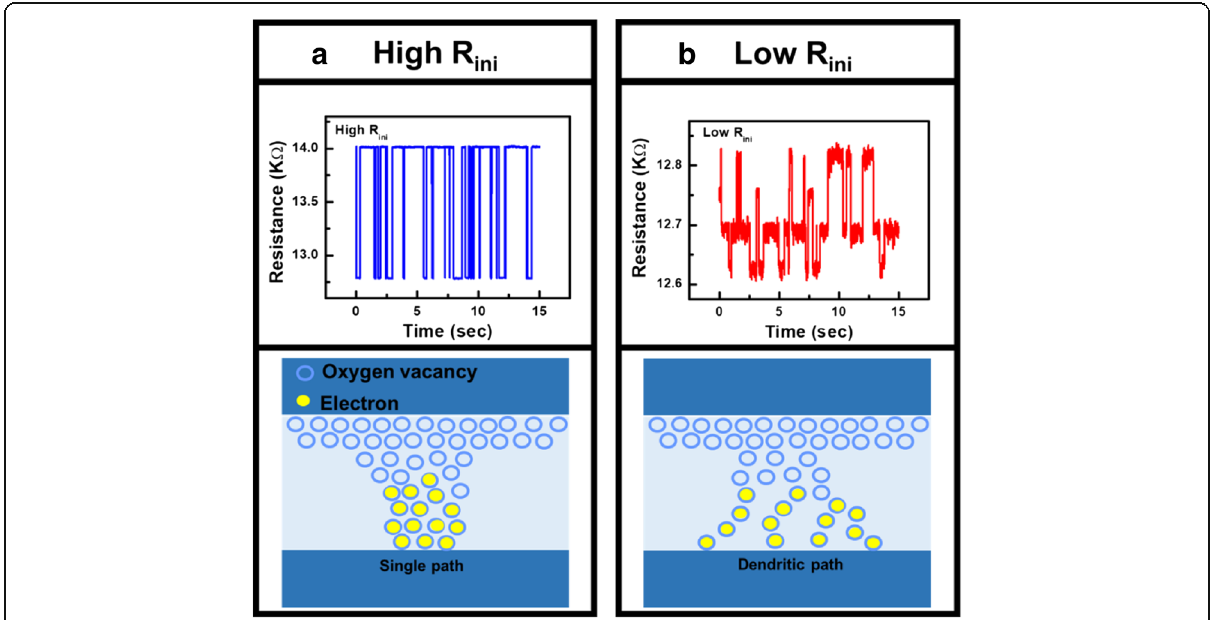
Fig. 11 The topographies of CF in cell with a high initial resistance and b low initial resistance are analyzed by its corresponding RTN data. Occurrence of multiple resistance fluctuation in cells with low initial resistance and more intrinsic Vo- verifies the existence of dendritic CFs in TMO